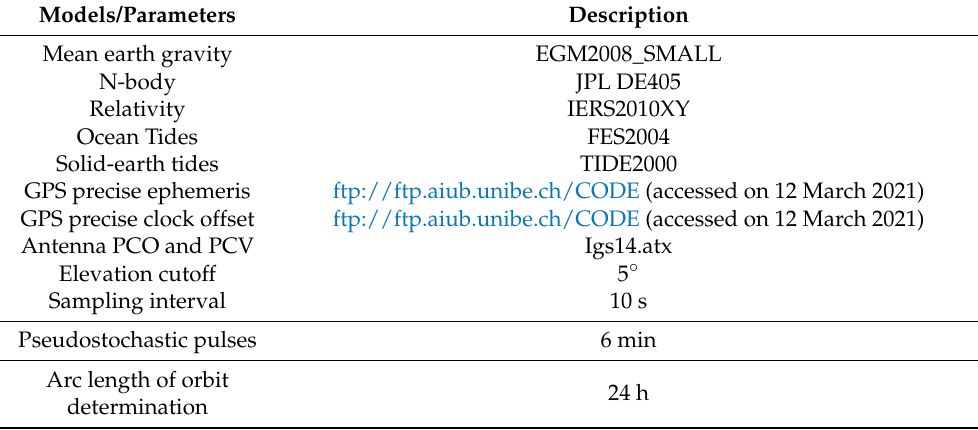
Table 4. RD orbit determination strategies of COSMIC-2.